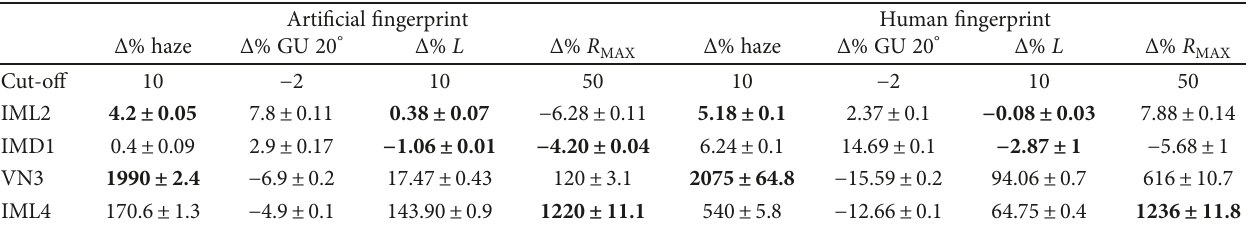
Figure 7: Score and loading plots from PCA performed with a reduced number of variables. Score plot: (a) closed red marks represent “ visible ” and empty marks represent “ not visible. ” Loading plot (b). Table 5: Cut-o ff values and average results of the four signi fi cant parameters on selected surfaces using arti fi cial and human fi